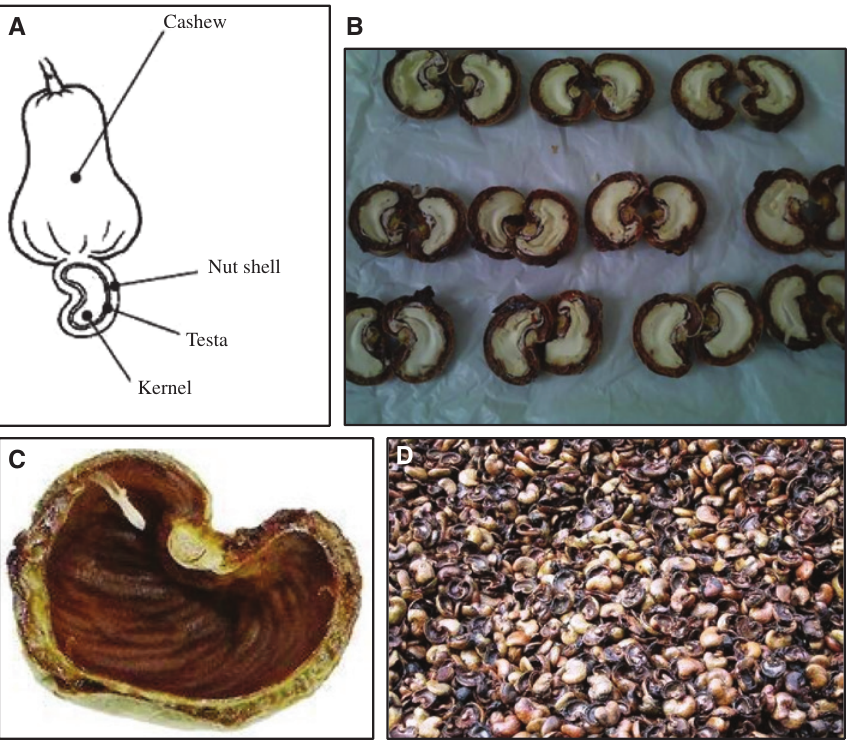
Figure 1: (A) Schematic representation of cashew fruit, (B) cashew nuts, (C) CNS and (d) drying process of